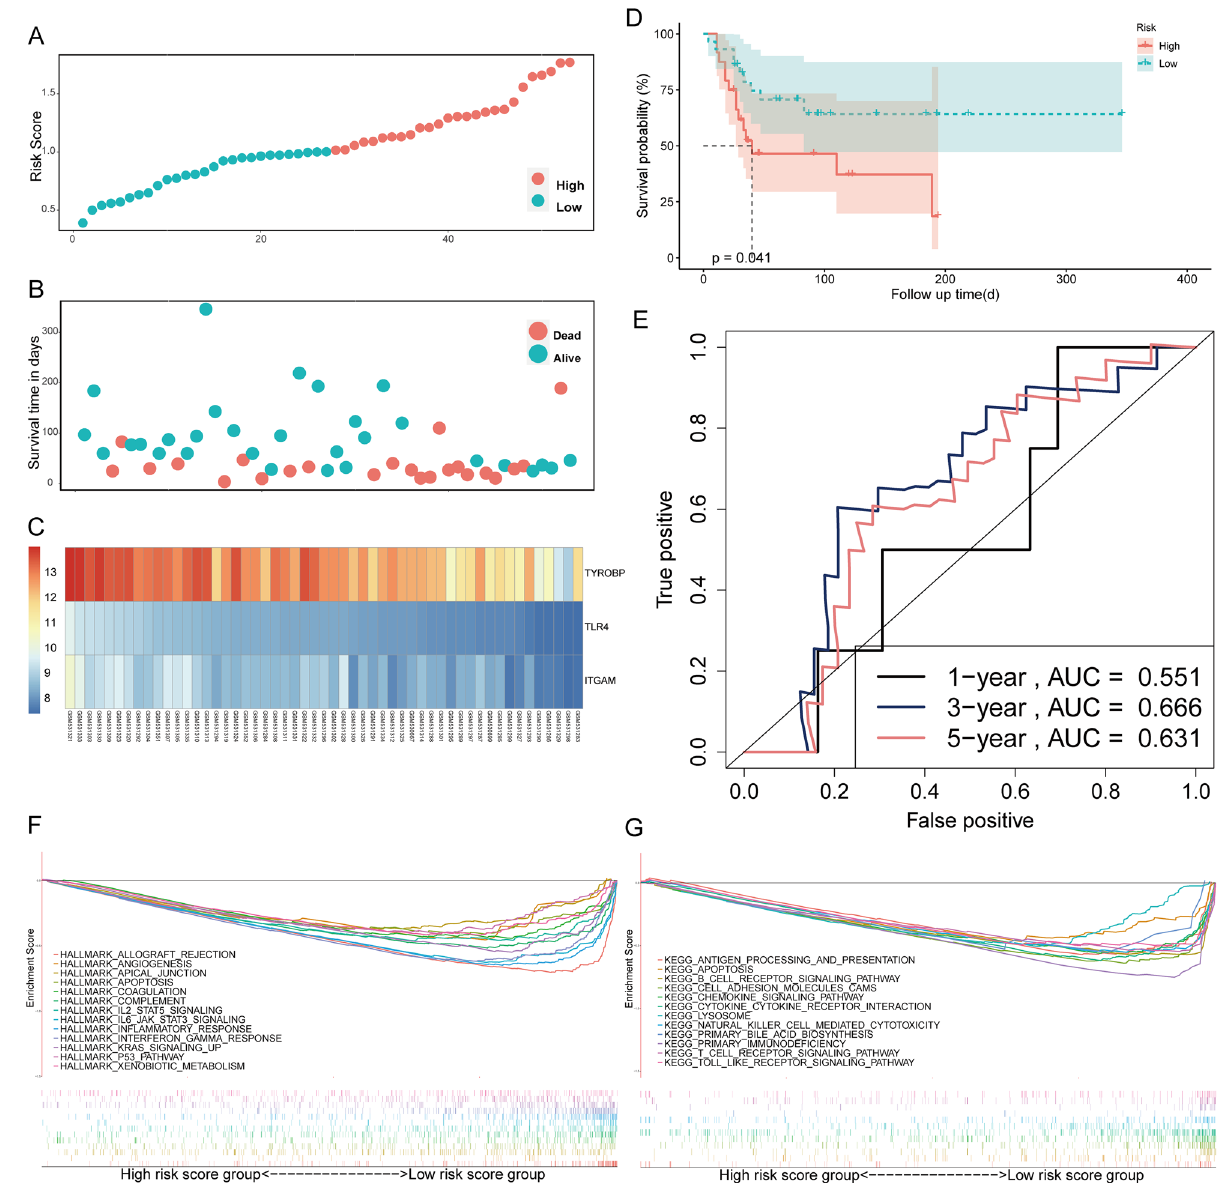
Figure 3. Validation of the prognostic gene signature for osteosarcoma using GSE21257 cohort. ( A ) Classification of patients into different risk groups based on the median risk score. ( B ) Distribution of patients’ survival time and status. ( C ) Heatmap of expression profiles of included risk score related genes. ( D ) Kaplan– Meier survival curves between low- and high-risk groups in the GSE21257 cohort. ( E ) ROC curves of the risk score diagnostic ability. GSEA in the Hallmarks ( F ) and KEGG ( G ) gene set between group high (n = 42) and low (n = 42) of the risk score in the TCGA